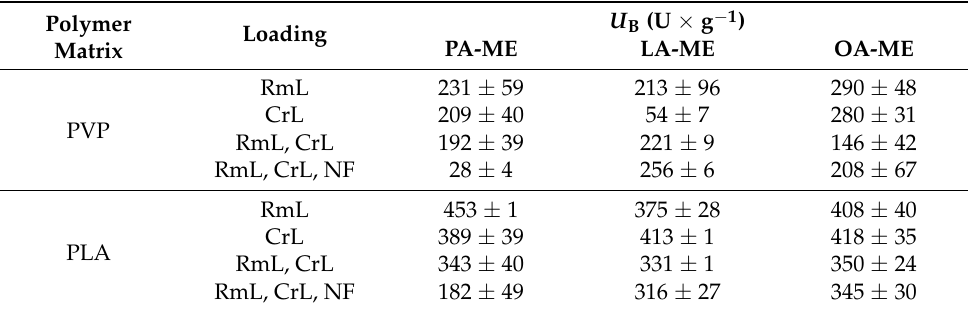
Table 3. Investigation of the biocatalytic activity ( U B ) of lipases (CrL or RmL) formulated in polymeric nanofibers (PVP or PLA). The effect of multilayered nanofiber fabrication and nadifloxacin (NF) loading on U B in lipase catalyzed hydrolysis of fatty acid methyl esters ( PA-ME : methyl palmitate, LA - ME : methyl linoleate and OA-ME : methyl oleate). This table summarizes the specific biocatalytic activity values obtained by gas chromatography of samples taken 2 h after the start of the reactions. Activity values were determined by the following equation: U B = n s × c × ( t × m B ) − 1 , where c is